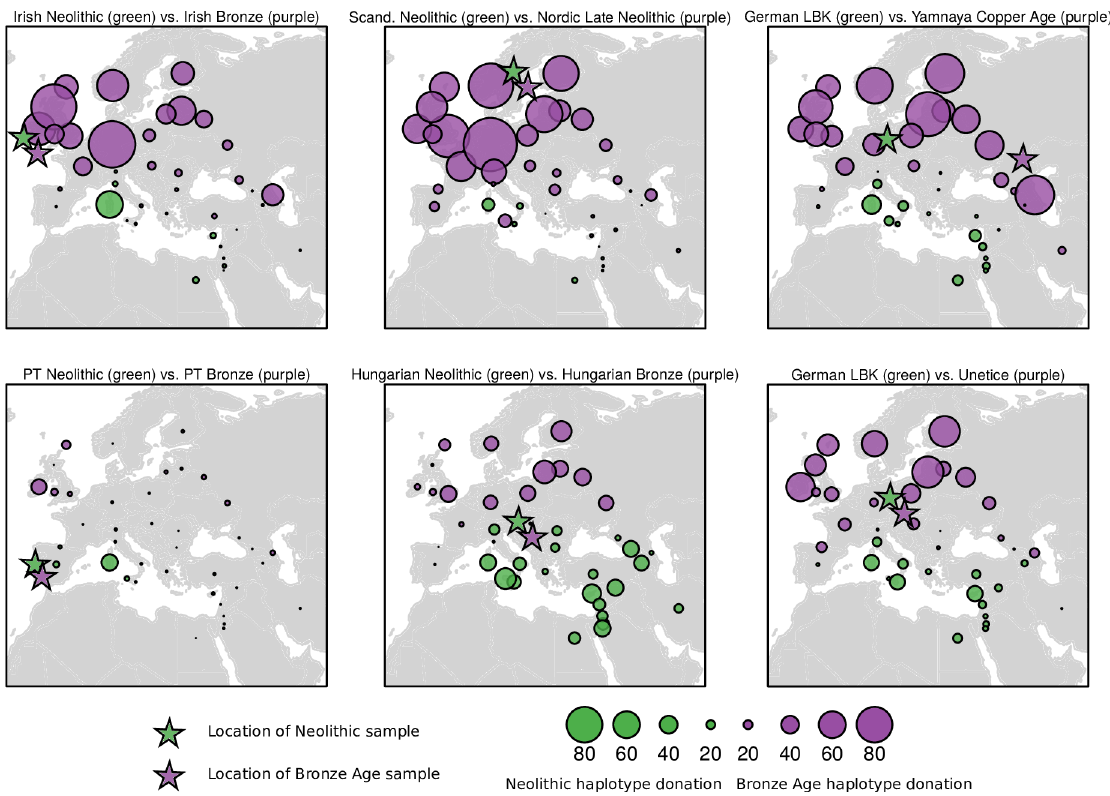
Fig 3. Total variation distance between vectors of median haplotype donation from Bronze Age (purple) and Neolithic (green) samples from different regions in Europe to modern populations. Circle size varies accordingto the absolute difference betweenNeolithicand Bronze Age samples in terms of the numberof haplotypes donatedto present day populations. Regardless of the geographicallocationsof the ancientsamples, Neolithicsamplestend to donate comparatively more haplotypes to Southern populations, whileBronze Age show the oppositepattern, with an excess of haplotypecontribution to NorthernEuropeans.This pattern is present, but distinctly weaker in the Portuguese Neolithic-Bronze Age comparison.